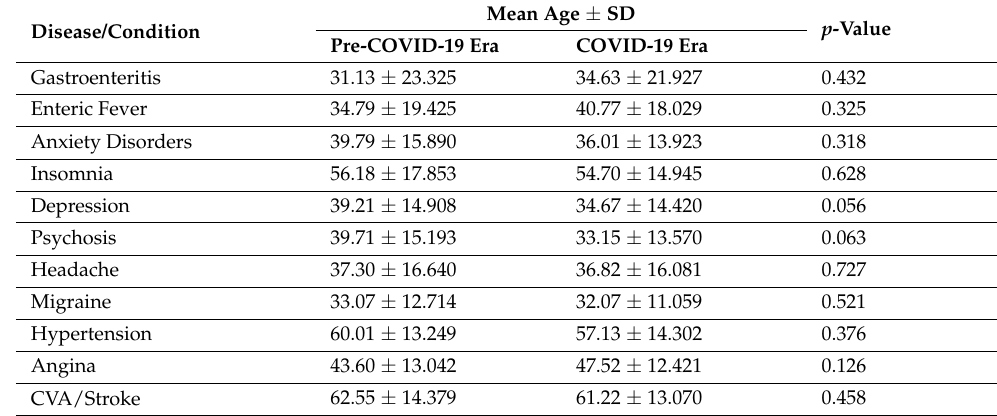
Table 7. Relationships between age and prevalence of the diseases in the pre-COVID-19 and COVID- 19